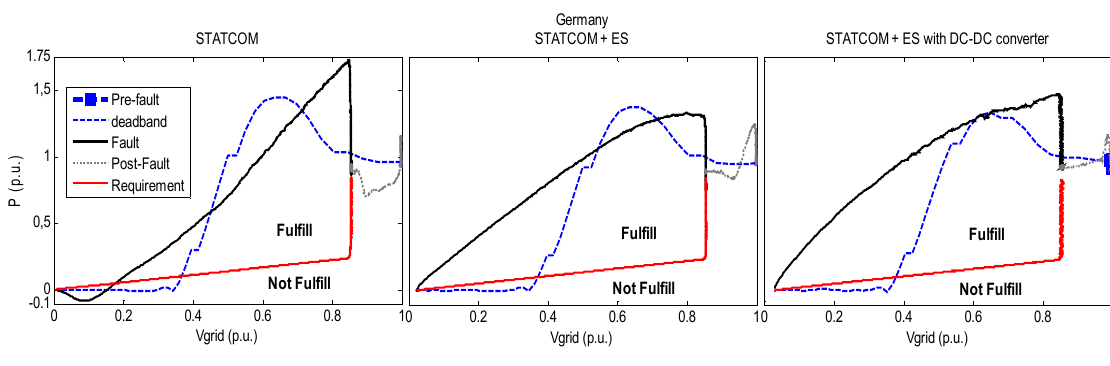
Figure 18. STATCOM active power evolution through the voltage dip, German case.